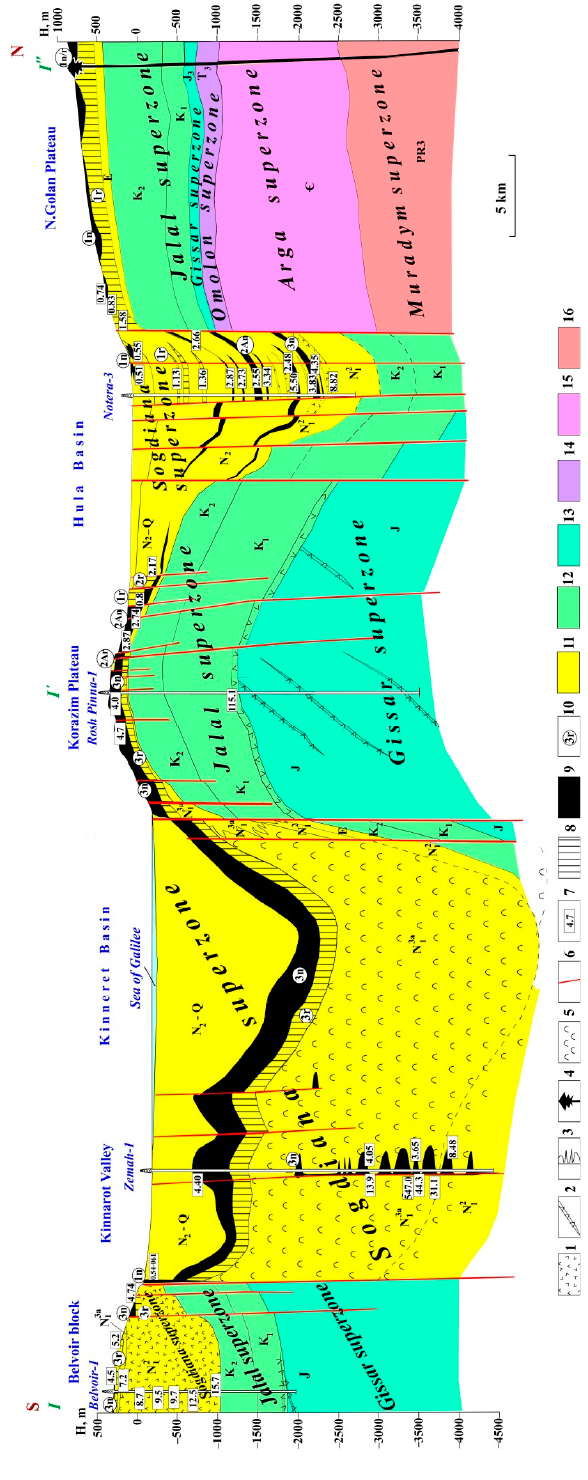
Figure 7. Paleomagnetic profile Kinnarot—Hula (its location is shown in Figures 1, 5 and 6). (1) basic traps, (2) basic dykes, (3) gabbro, (4) volcanic cones, (5) evaporite sediments, (6) faults, (7) radiometric dating, (8) reversal polarity, (9) normal polarity, (10) indexes of Plio-Pleistocene paleomagnetic scale, (11) Sogdiana superzone, (12) Jalal superzone, (13) Gissar superzone, (14) Omolon superzone, (15) Arga superzone, (16) Moradym superzone. The primary utilized sources (besides publications presented in captions for Figures 5 and 6) are: